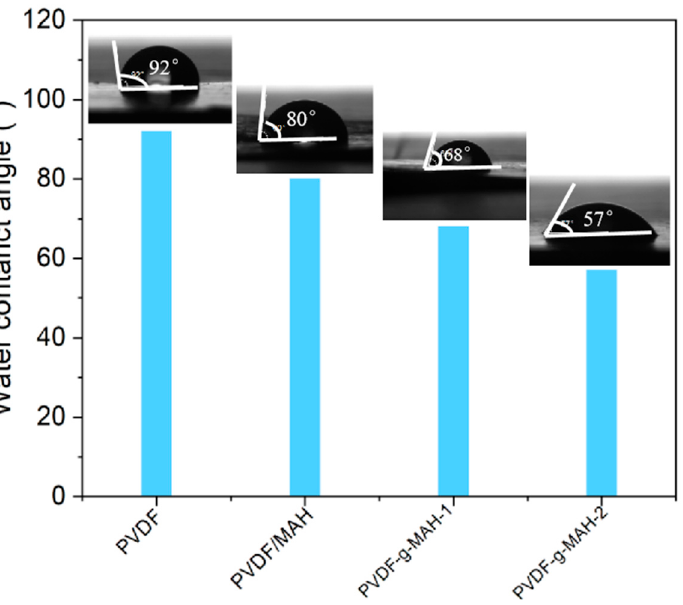
Figure 2. Water contact angles of pure PVDF, PVDF/MAH, PVDF-g-MAH-1 and